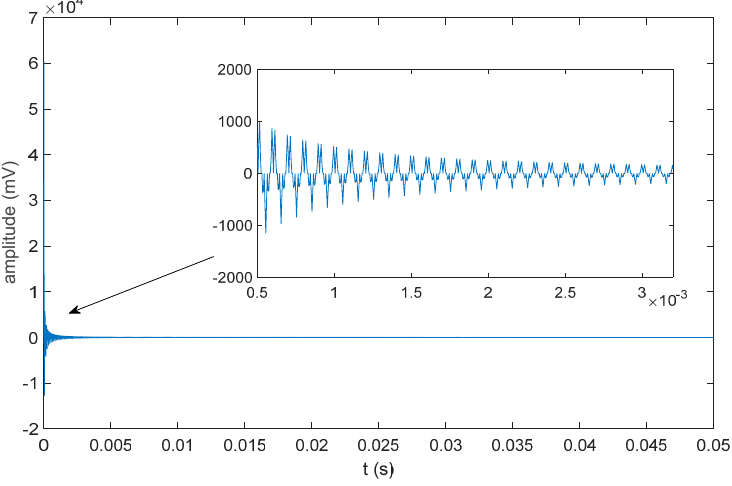
Figure 13. Oscillogram of the sound source signal.